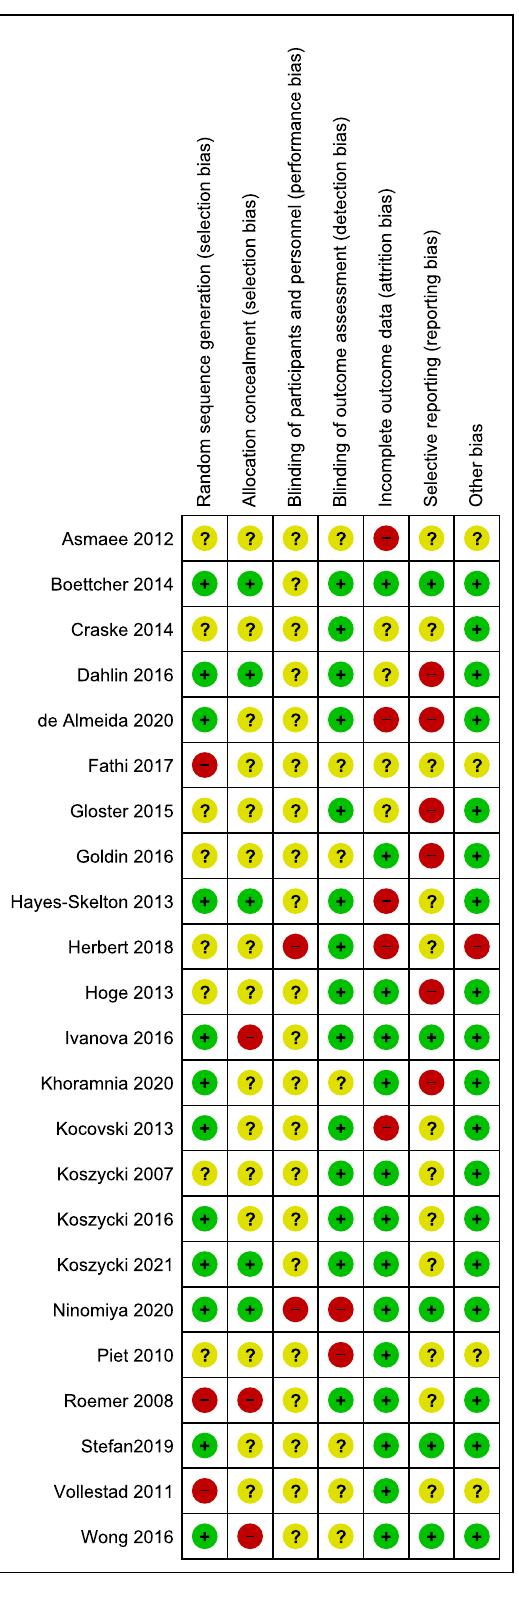
Figure 2. Risk of bias